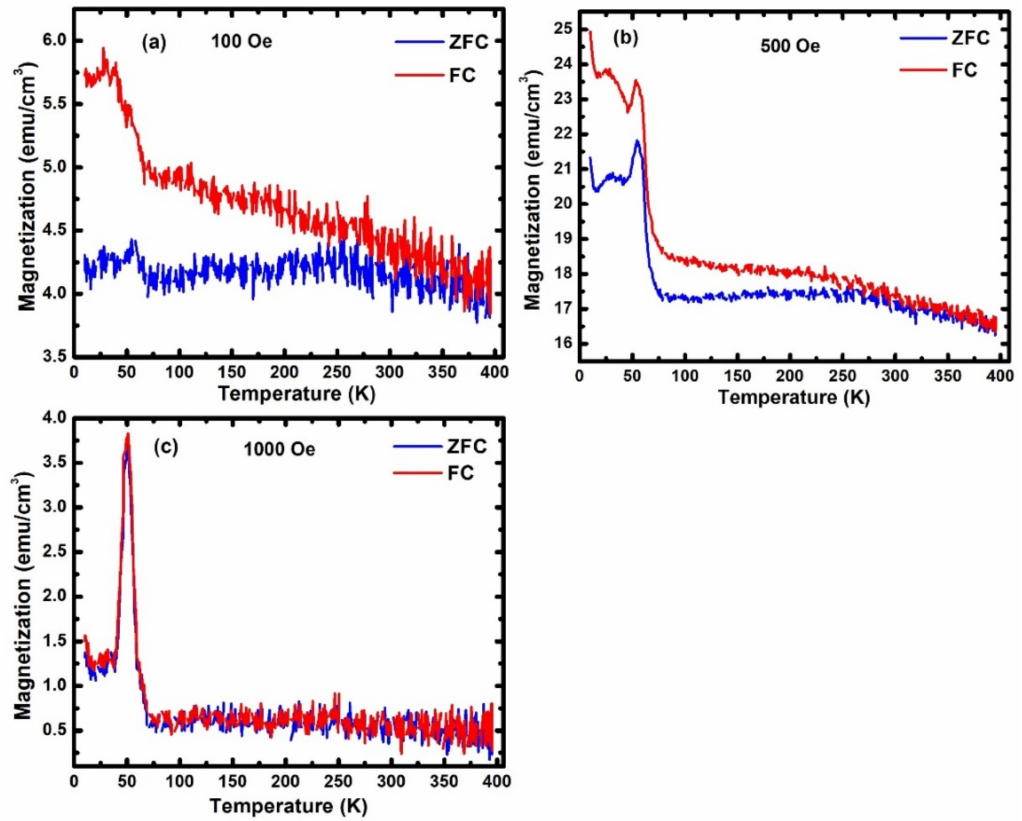
Figure 5. ZFC & FC magnetization curves measured on V 2 O 3 films at different applied magnetic fields. ( a ) 100 Oe; ( b ) 500 Oe; ( c ) 1000